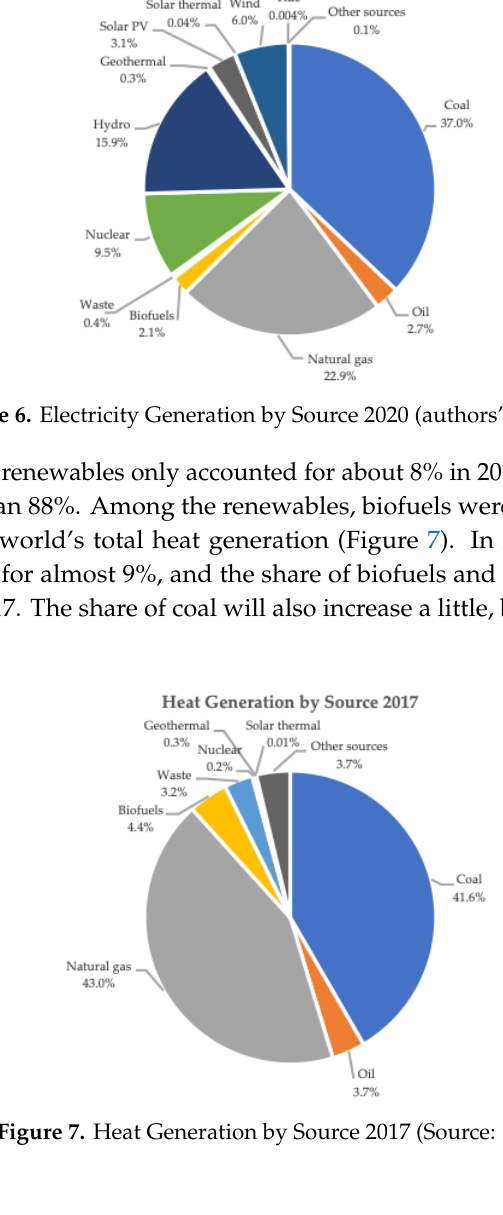
Figure 8. Heat Generation by Source 2020 (authors’ forecasts). According to OECD (Organisation for Economic Co-operation and Development) data [62], renewable energy production (as a percentage of primary energy supply) in 2017 was the largest in the Democratic Republic of the Congo (97.38%), Ethiopia (90.76%), and Iceland (87.9%). In contrast, the countries that did not use at all renewable energy sources are Bahrain, Brunei, Kuwait, Oman, and Qatar (Figure 9). OECD data state that African countries used a bigger percentage of renewable energies in their total energy supply, compared to European countries and the USA. According to our forecasts for 2020, these percentages are not going to change radically: the Democratic Republic of the Congo will still have the biggest share of renewable energy (98.2%), and Ethiopia and Iceland will follow, while the countries that did not use at all renewables will continue to do so in 2020, too.